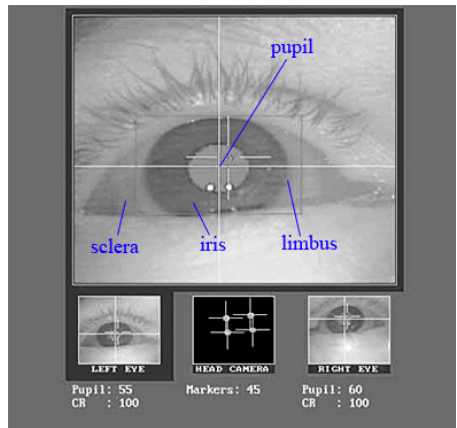
Figure 1. The composition of the eye. Note: The pupil is the area located in the center of the iris. The limbus is the boundary of iris, which is surrounded by the